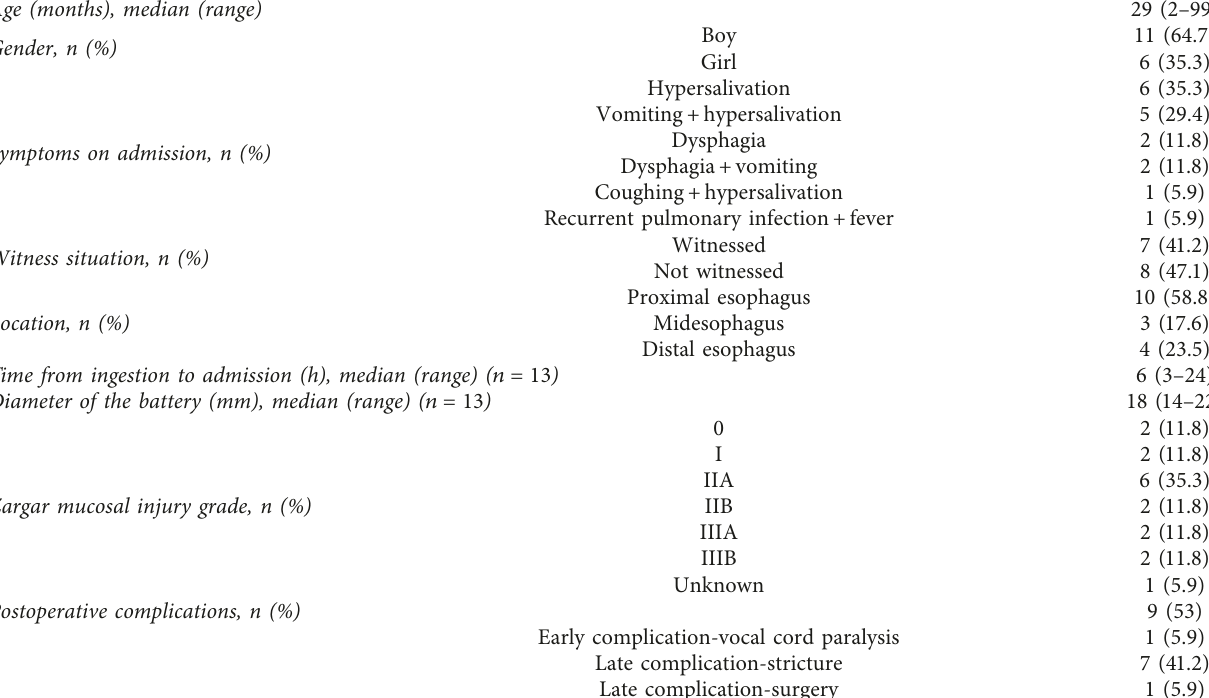
Table 1: Overall characteristics ( n �